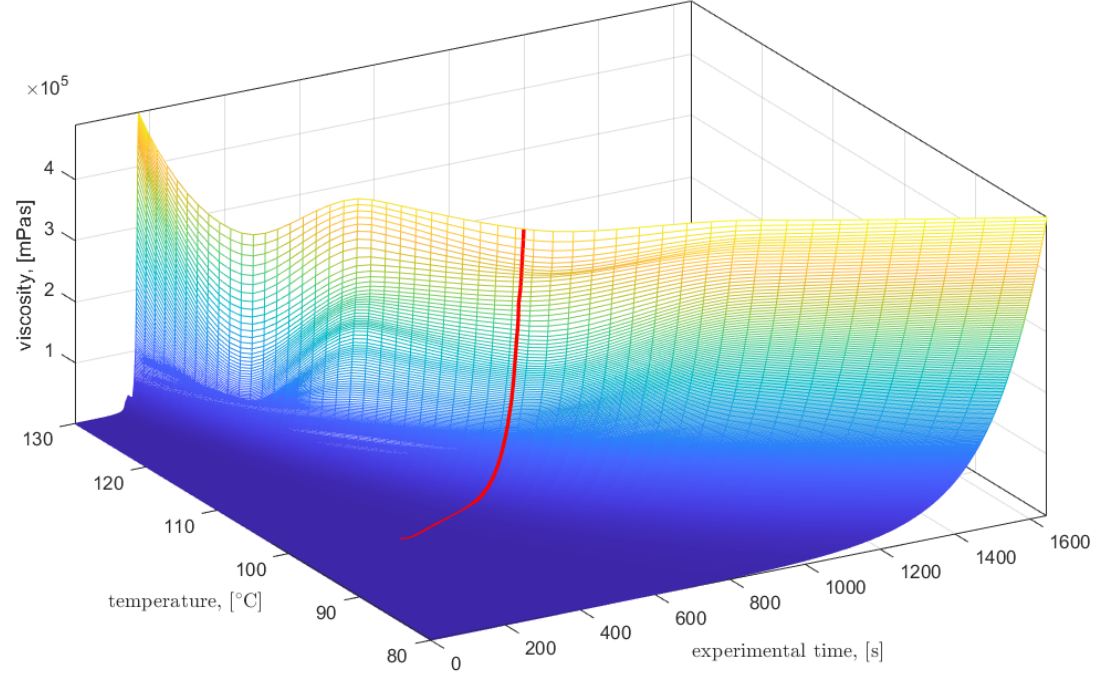
Figure 4. Viscosity field of the resin system (Epinal 77.55-A1/Epinal 77.55-B1) depending on time and temperature, as found from offline characterization, with an overlay of the temperature-time path, as measured with the in-mold DC sensor.